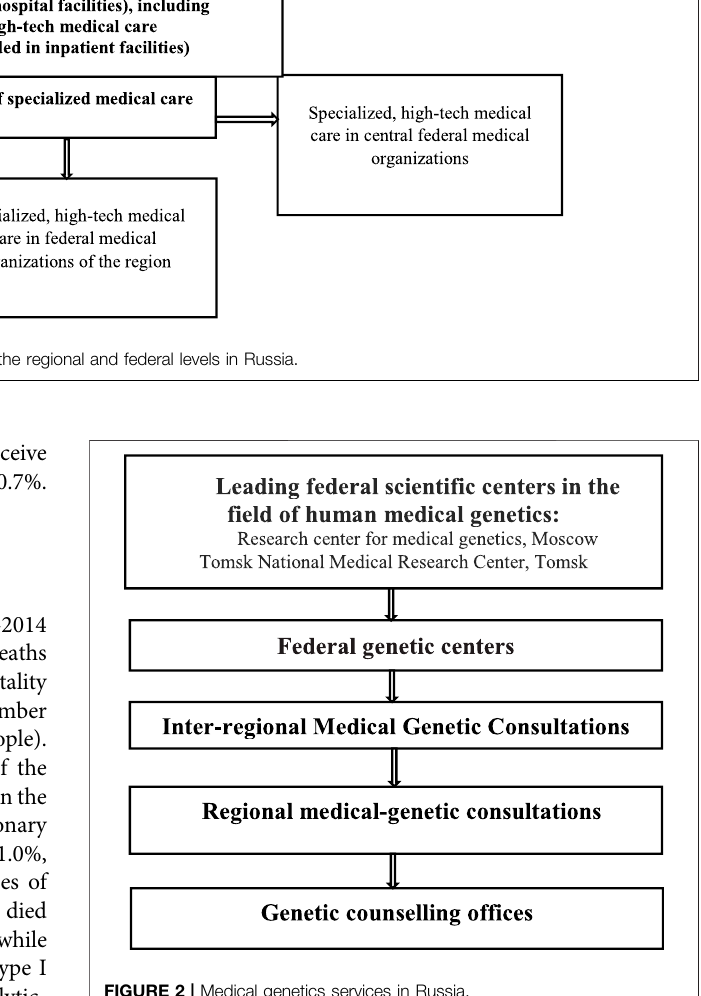
FIGURE 2 | Medical genetics services in